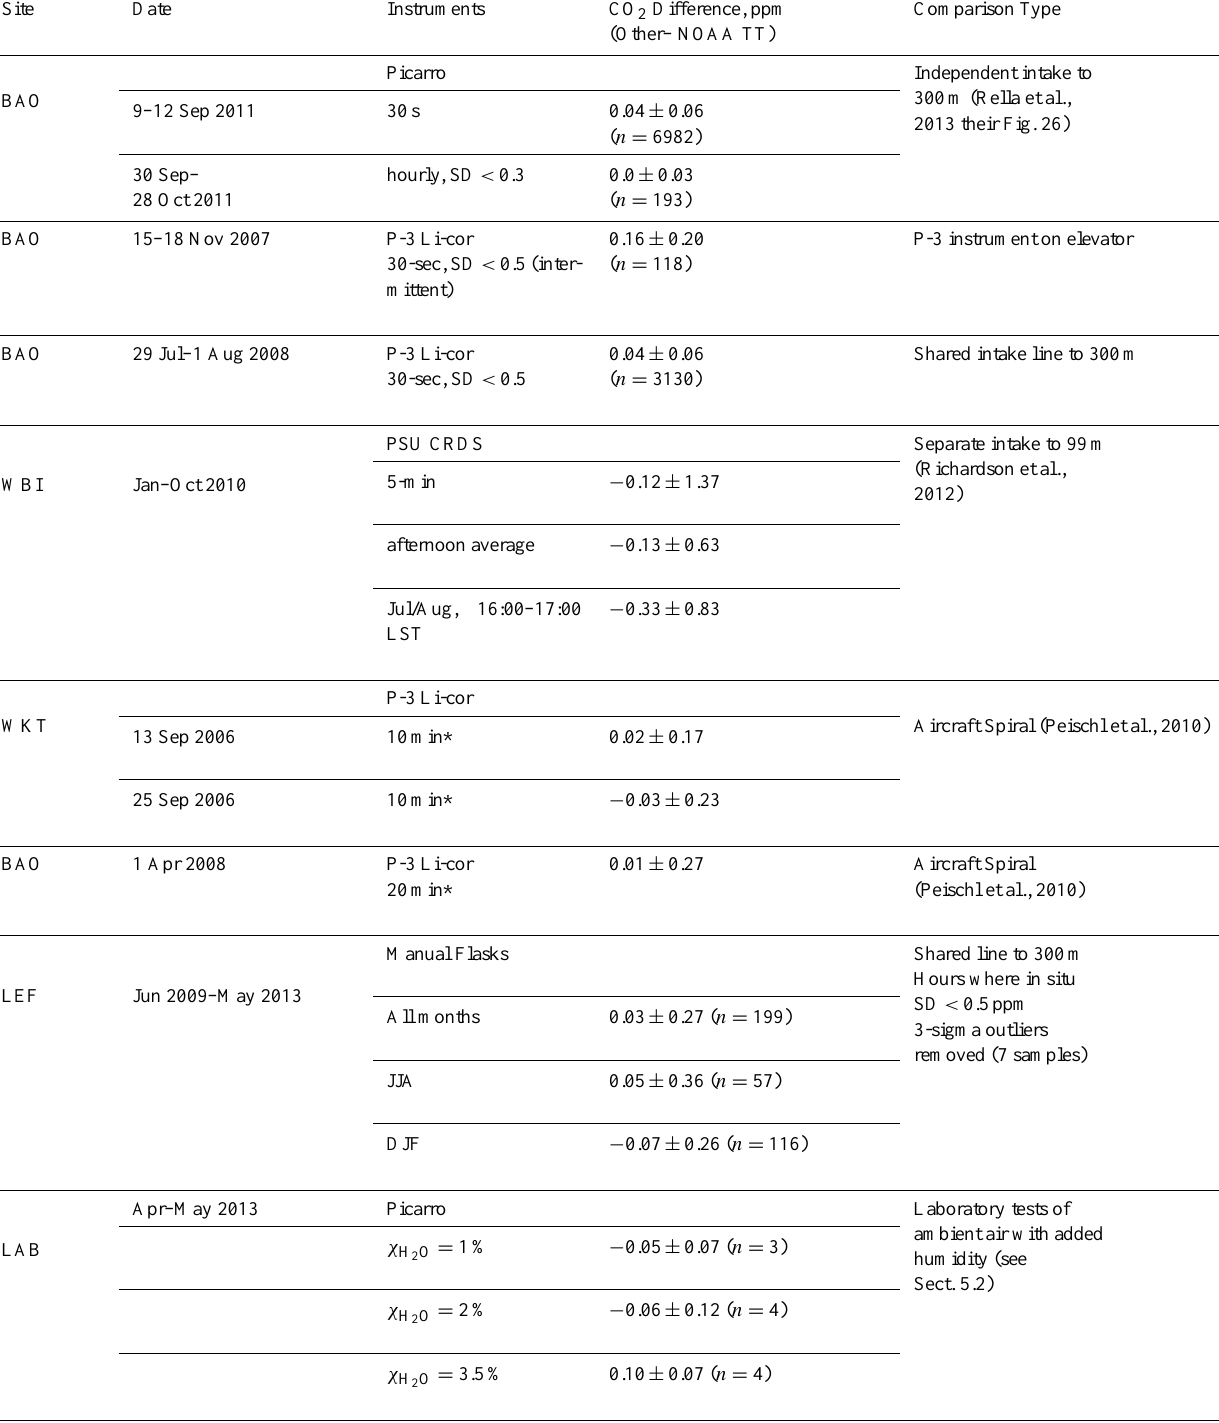
Table 8. Summary of comparisons between NOAA ESRL Tall Tower Li-cor CO 2 and other CO 2 measurements.